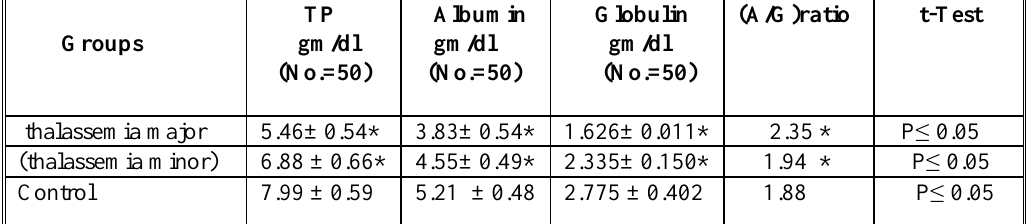
Table 1 : Total protein (TP), albumin,globulin and (A/G) ratio levels in sera of β- thalassemia major, minor thalassemia patients and normal control .